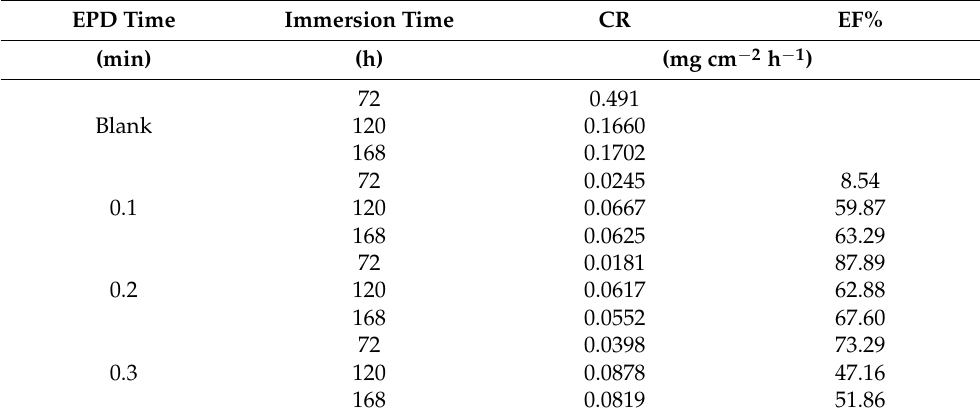
Table 1. Results of Analysis of time effect on EPD process and calculation of the corrosion rate of AA5052 uncoated and coated with Chitosan inhibitor.